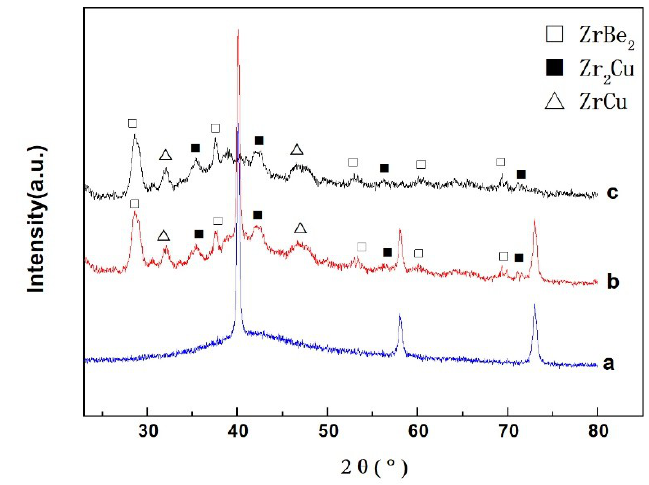
Figure 11. The X-ray diffraction patterns of the materials (curve a corresponds to the metallic glass Zr 41.2 Ti 13.8 Cu 12.5 Ni 10 Be 22.5 annealed at 703 K, curve b corresponds to the W particles/Zr 41.2 Ti 13.8 Cu 12.5 Ni 10 Be 22.5 metallic glass matrix composite annealed at 703 K, curve c corresponds to the W particles/Zr 41.2 Ti 13.8 Cu 12.5 Ni 10 Be 22.5 metallic glass matrix composite as-cast).